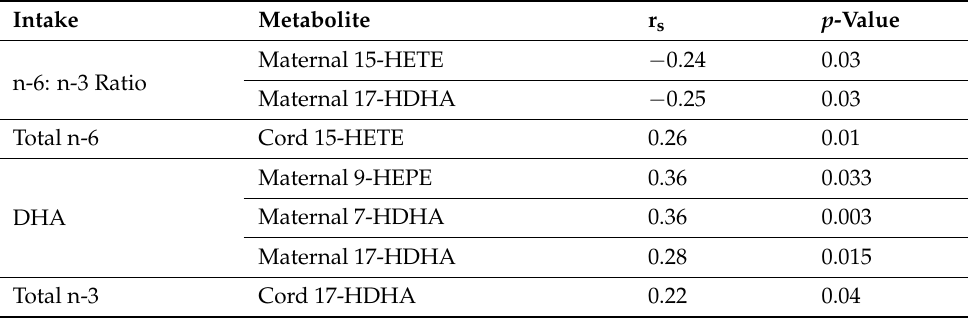
Table 8. Correlations between dietary intakes and metabolite plasma levels.